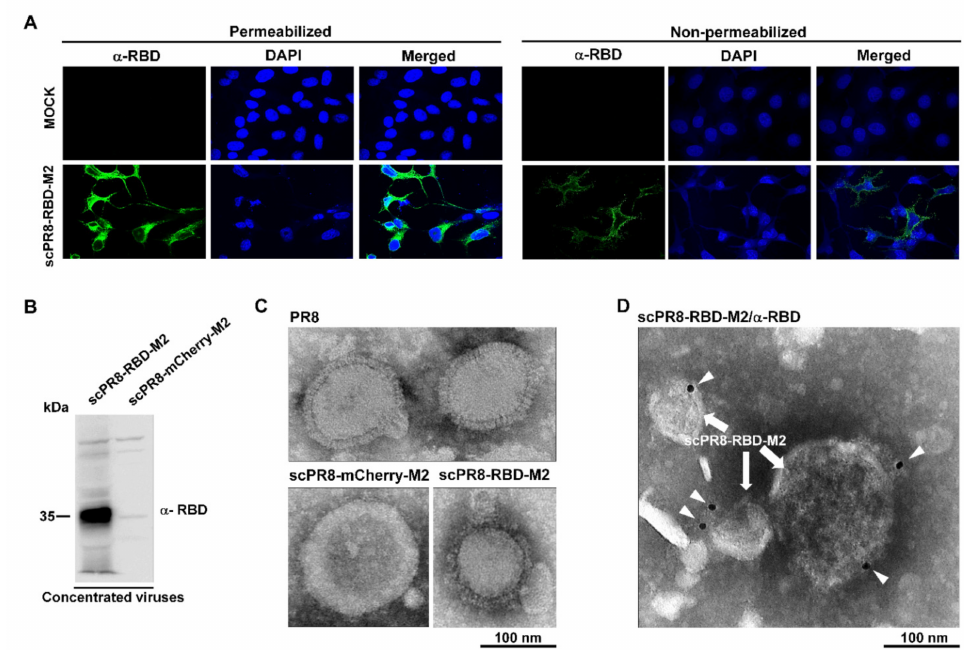
Figure 3. Presentation of RBD on the membrane of infected cells and viral particles. ( A ) Confocal microscopy displayed surface expression of a membrane anchored-RBD in infected MDCK-HA. MDCK-HA cells were infected with scPR8-RBD- M2 and prepared under non-permeabilized and permeabilized conditions for IFA. The cells were probed with rabbit anti-spike RBD antibody. Goat anti-rabbit IgG antibodies conjugated with Alexa flour 488 was used as secondary antibody. ( B ) scPR8-RBD-M2 and scPR8-mCherry-M2 viruses were centrifuged through 20% glycerol in PBS and re-suspended with PBS. The purified viruses were subjected to ( B ) Western blot analysis, ( C ) negative staining and ( D ) immuno-labeling determined by transmission electron micrograph (TEM). The virus particles were labelled with rabbit anti-RBD monoclonal antibodies conjugated to 10-nm gold